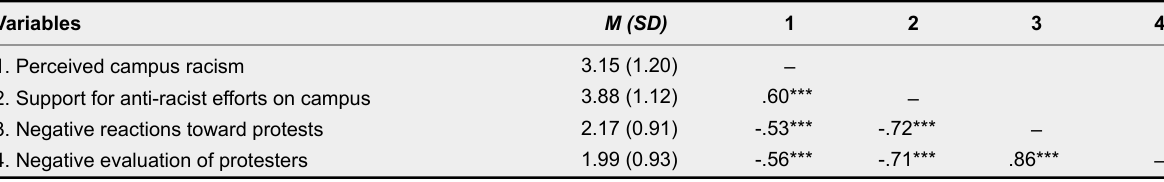
Means, Standard Deviations, and Intercorrelations Among Variables on Protest